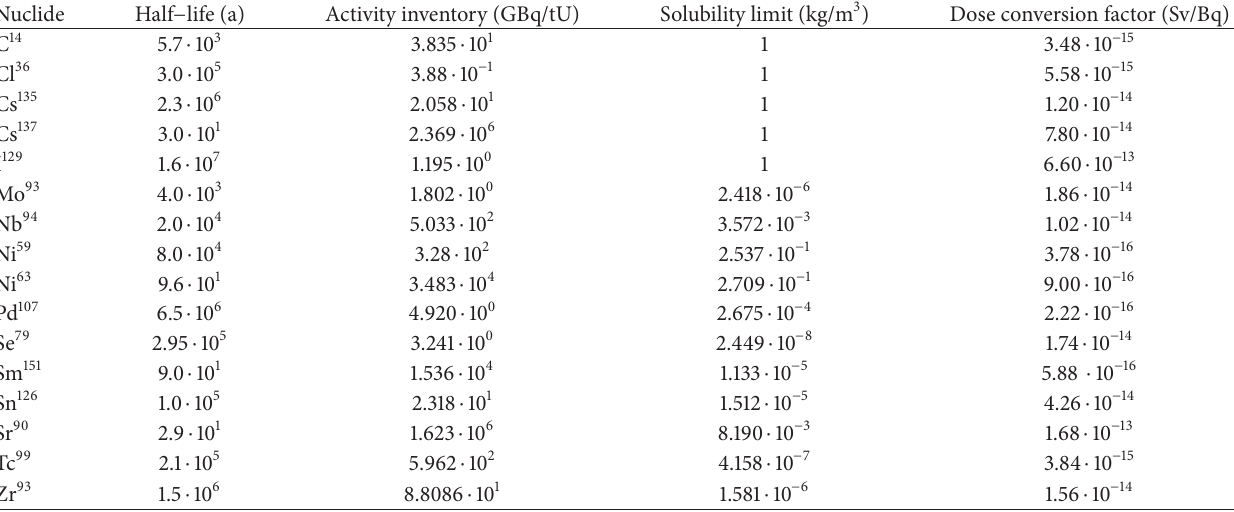
Table 5: Radionuclide